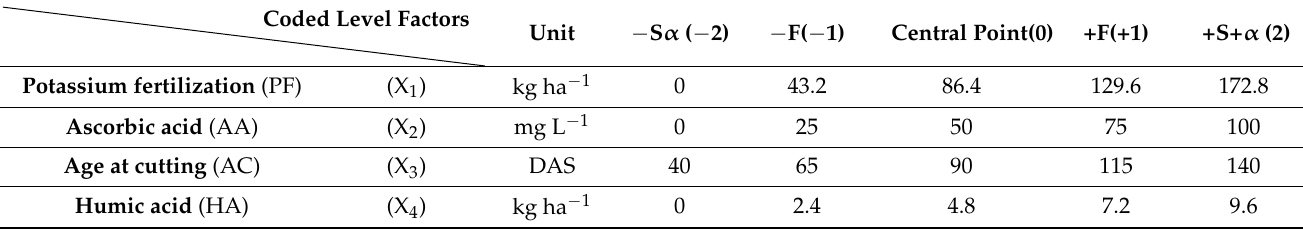
Table 2. Coded and actual levels of the studied factors in central composite design.